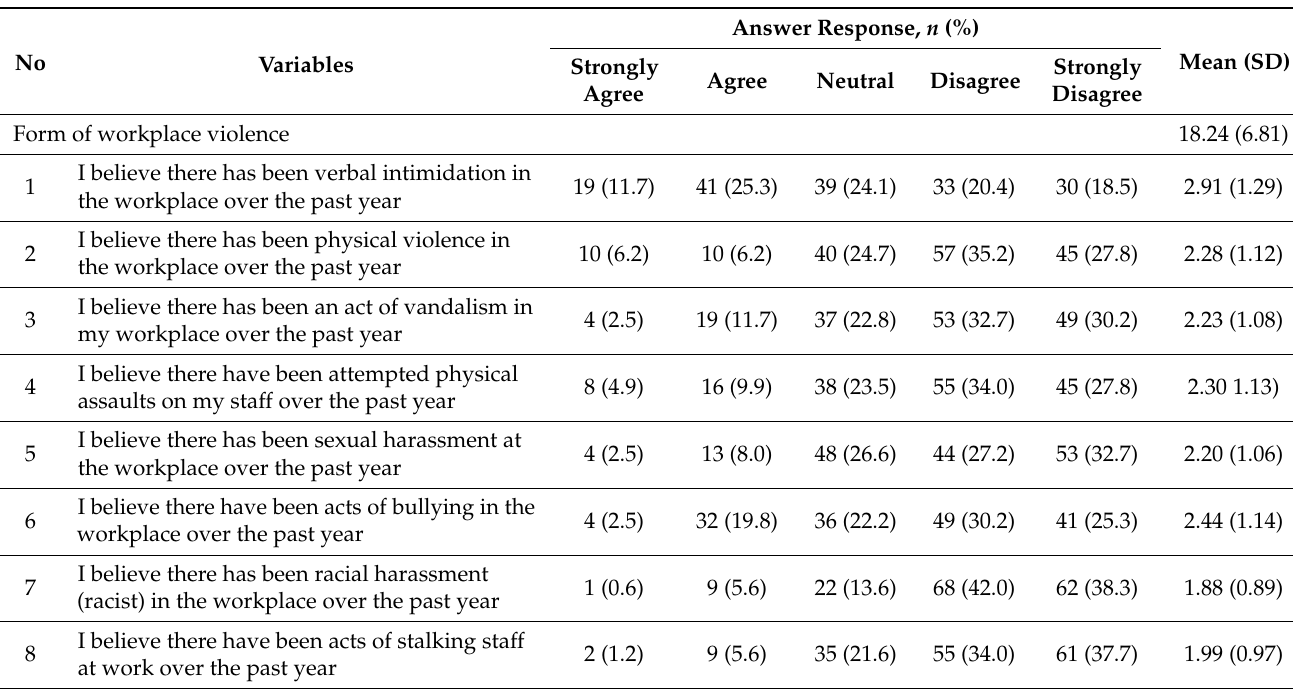
Table 4. Perception towards WPV prevention domain in PPWVP ( n =